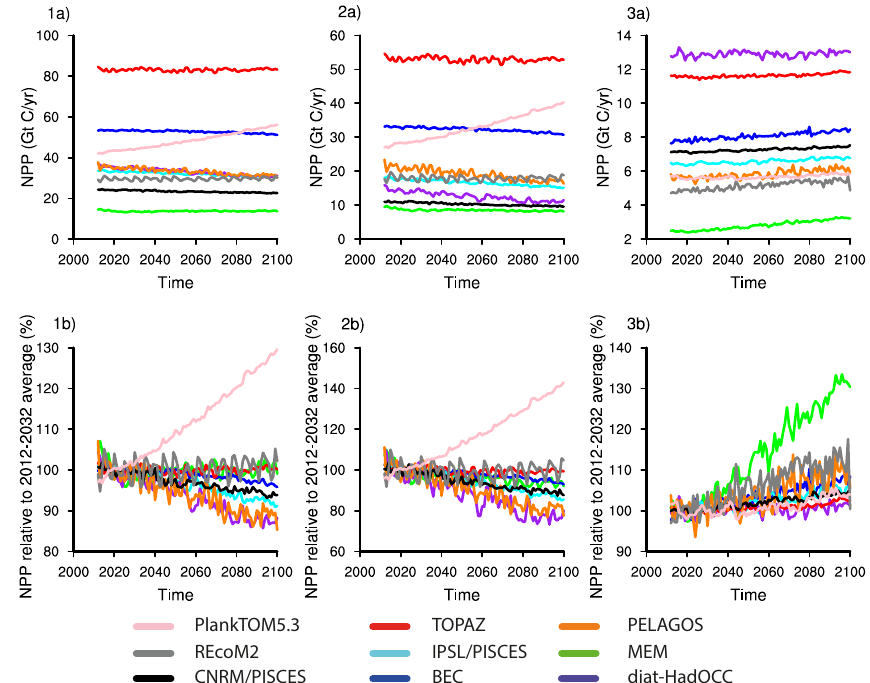
Figure 2. Projected trends in annual mean integrated net primary production (NPP) for the 2012–2100 period under RCP8.5, shown both in GtCyr − 1 (a) and in percent (b) . Panels (1a, b) show global values; panels (2a, b) and (3a, b) show low latitudes (30 ◦ S–30 ◦ N) and the Southern Ocean (90–50 ◦ S), respectively. Table 8. NPP changes (total and in percentage of the global value) in different regions. The Pacific upwelling region is shown in Fig. 3. Changes describe the difference between the 2012–2031 and the 2081–2100 average. Region Area in NPP in Multimodel Change Multimodel median % % median (GtCyr − 1 ) change (GtCyr − 1 ) Global 100 100 100 Low